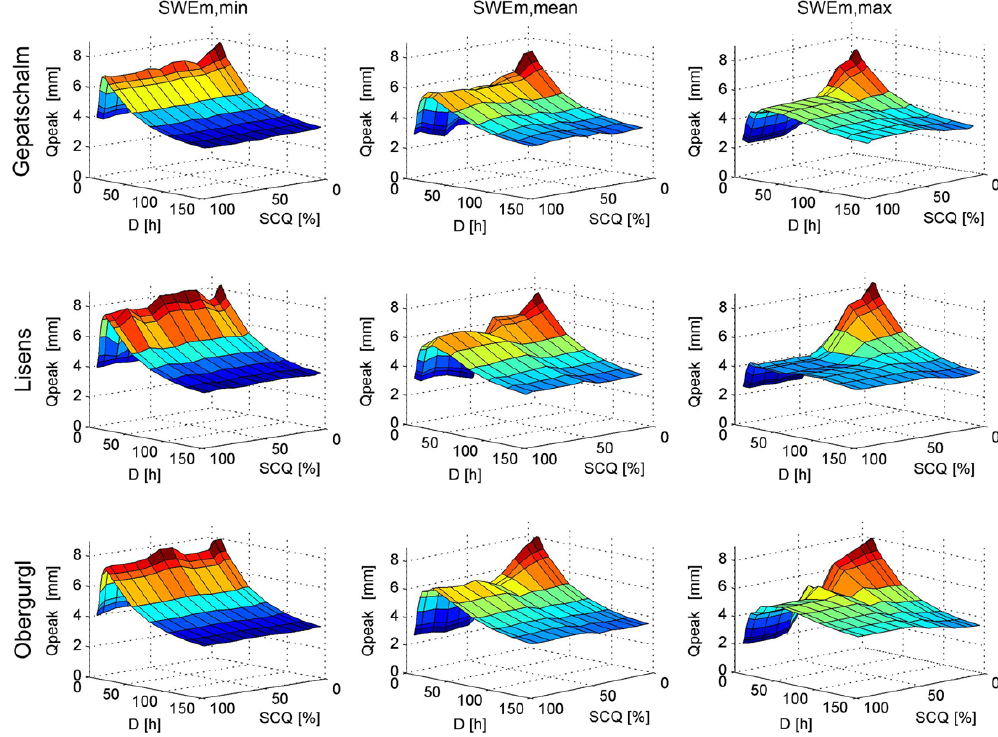
Fig. 6. Peak runoff distributions (Qpeak [mm]) as function of storm duration ( D [h]) and the snow cover quantile (SCQ [%]), separated for different catchments and SWE m